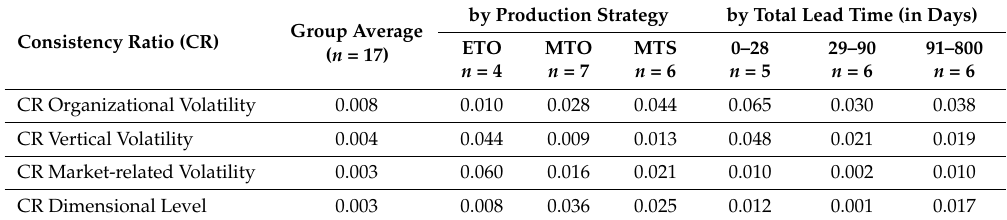
Table 4. Overview of CRs of